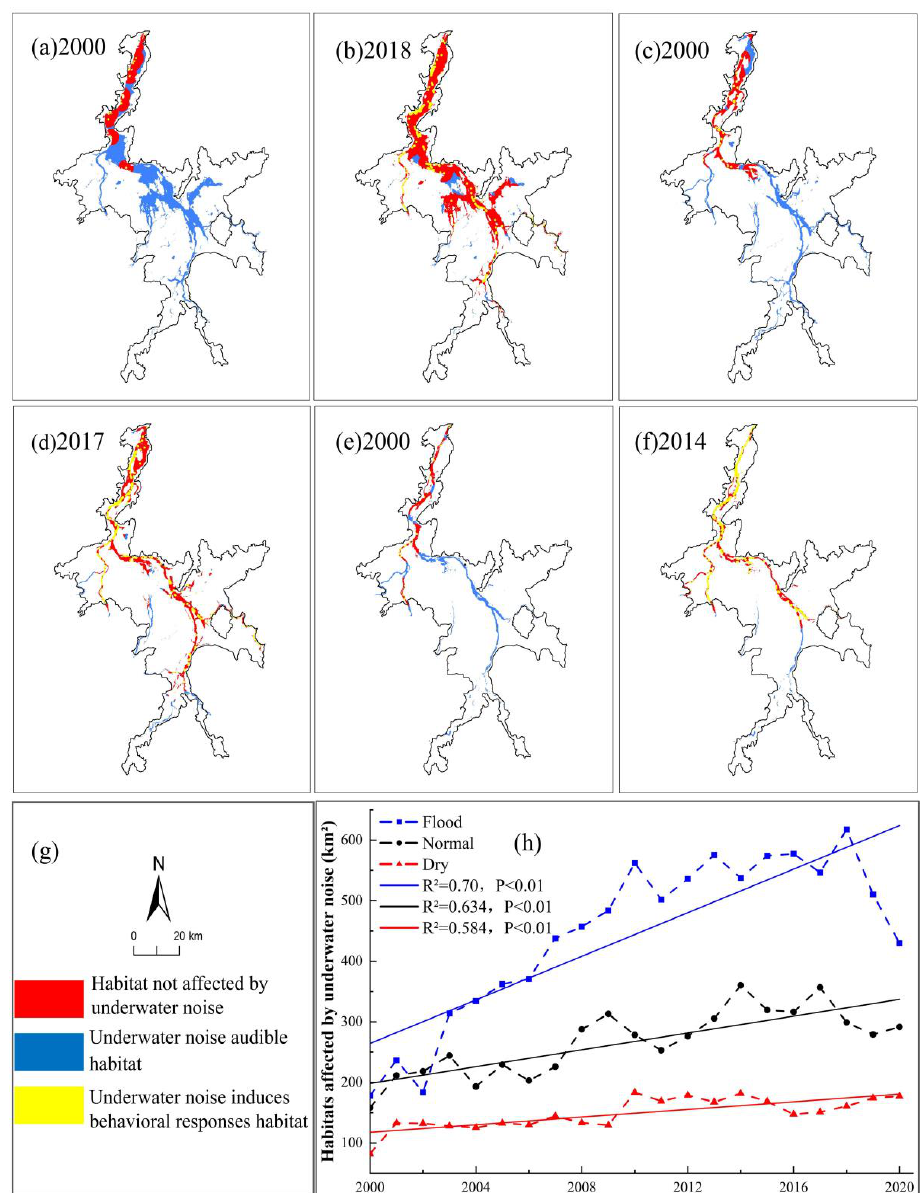
Figure 5. Distribution of porpoise habitats affected by underwater noise from sand mining vessels over the past 20 years. ( a , b ) Minimum and maximum impact areas in the flood season; ( c , d ) Minimum and maximum impact areas in the normal season; ( e , f ) Minimum and maximum impact areas in the dry season; ( g , h ) Area change of porpoise habitat affected by underwater